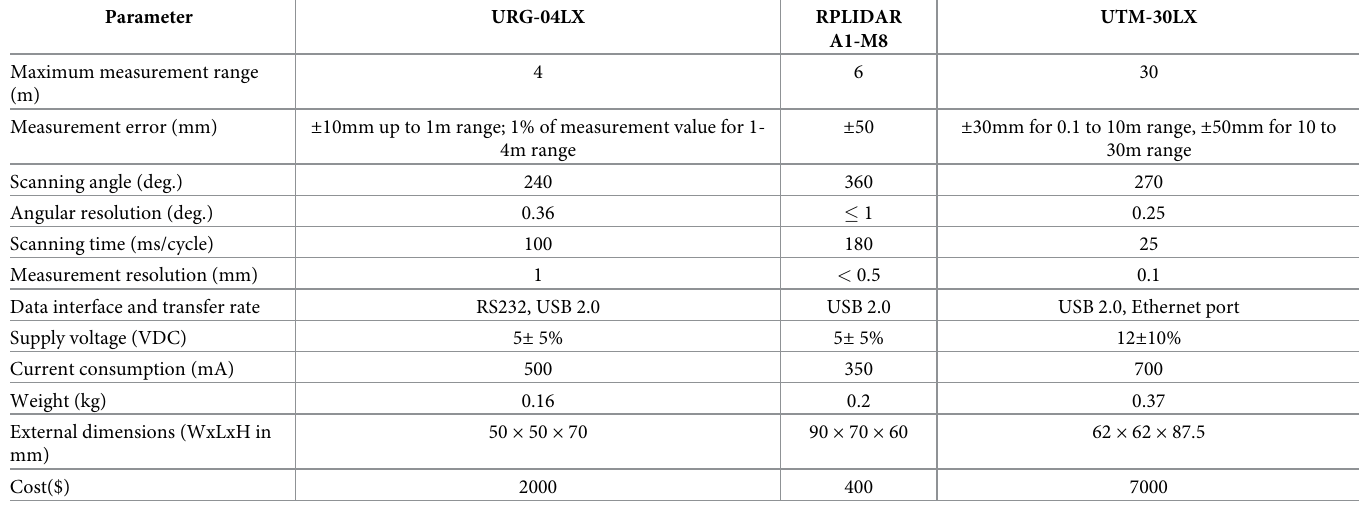
Table 1. Specification of 2D laser